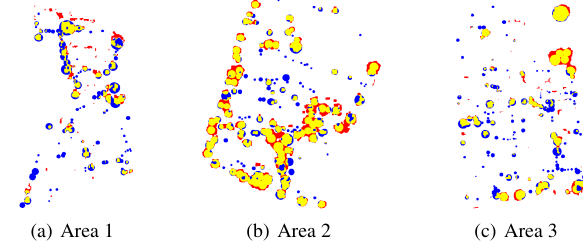
Figure 6: Pixel-wise result of class tree